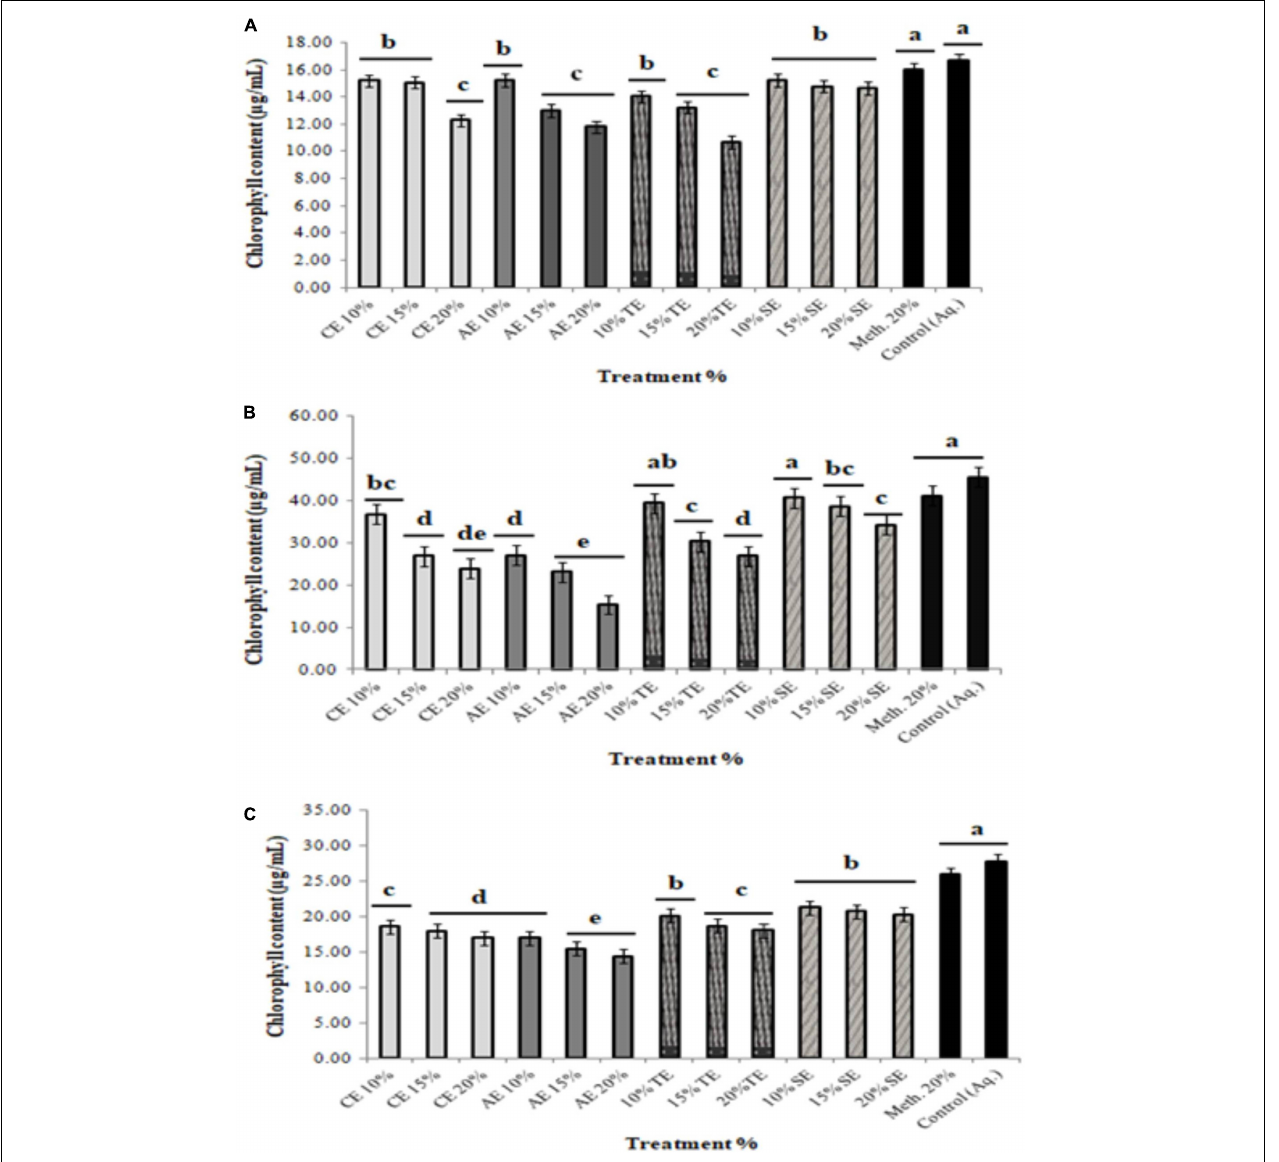
FIGURE 4 | Total chlorophyll content of weeds treated with 10, 15, and 20% extracts of castor (CE), artemisia (AE), wheat (TE), sorghum (SE), methanolic control (20%), and aqueous control. (A) Sinapis arvensis , (B) Lolium multiflorum , and (C) Parthenium hysterophorus . Values are presented as mean ± SEM ( n = 3). Bar values with different letters differ significantly at P <